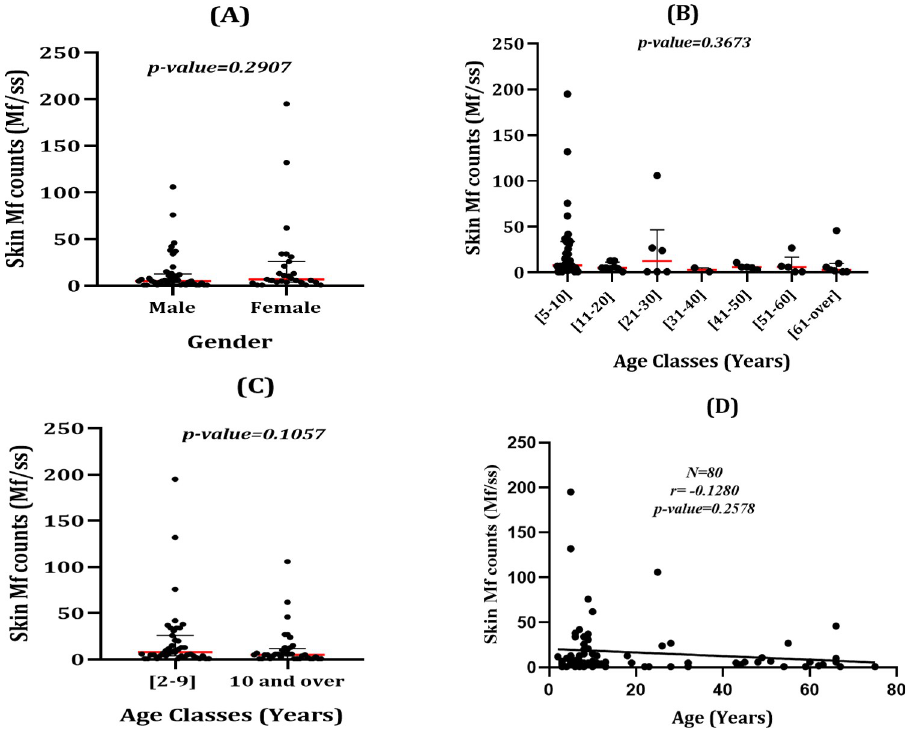
Fig 1. Distribution of skin Mf according to gender and age classes. (A) Distribution of skin Mf between males and females; (B) Distribution of skin Mf within the different age classes; (C) distribution of skin Mf counts between children younger than 10 and individuals aged 10 years and over; (D) Correlation between skin Mf counts and age.